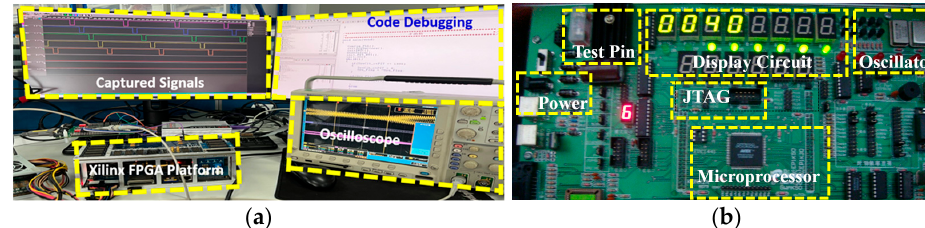
Figure 7. ( a ) Test process observed from Xilinx FPGA. ( b ) Single-chip microcomputer data processing display circuit.